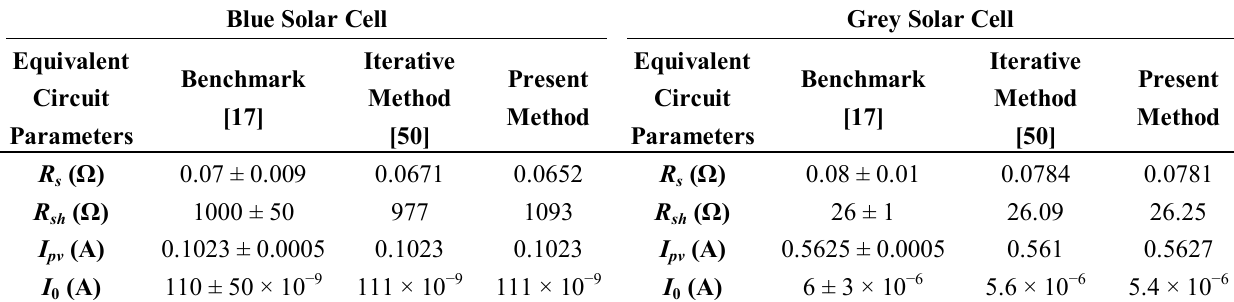
Table 2. Characteristic of blue solar cells and grey solar cells